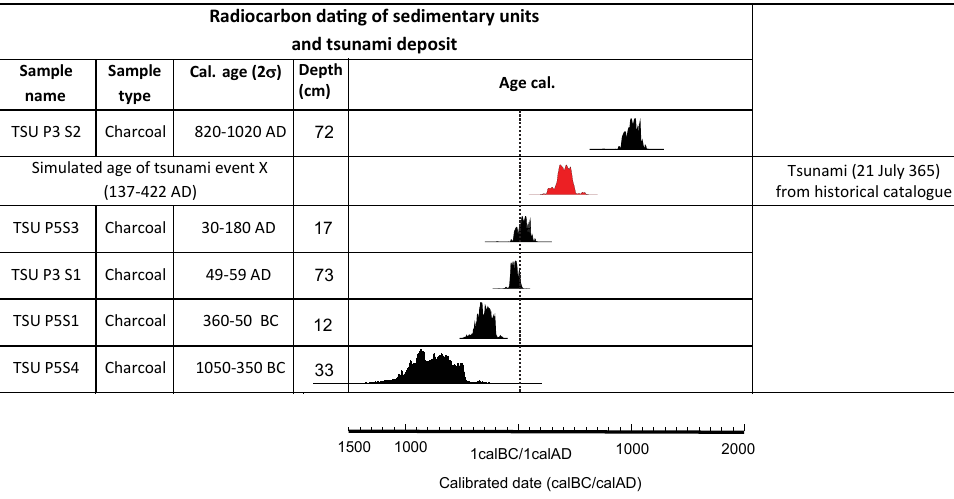
Figure 4. Radiocarbon dating calibrated with probability density function (pdf) using Oxcal version 4.2 (Bronk-Ramsey, 2009) and chronol- ogy of sedimentary layers and tsunami record of trenches at Kefr Saber. The dating characteristics are in Table 2a. The Bayesian dating simulation of the white sandy unit in Fig. 3b can be correlated with the AD365 tsunami